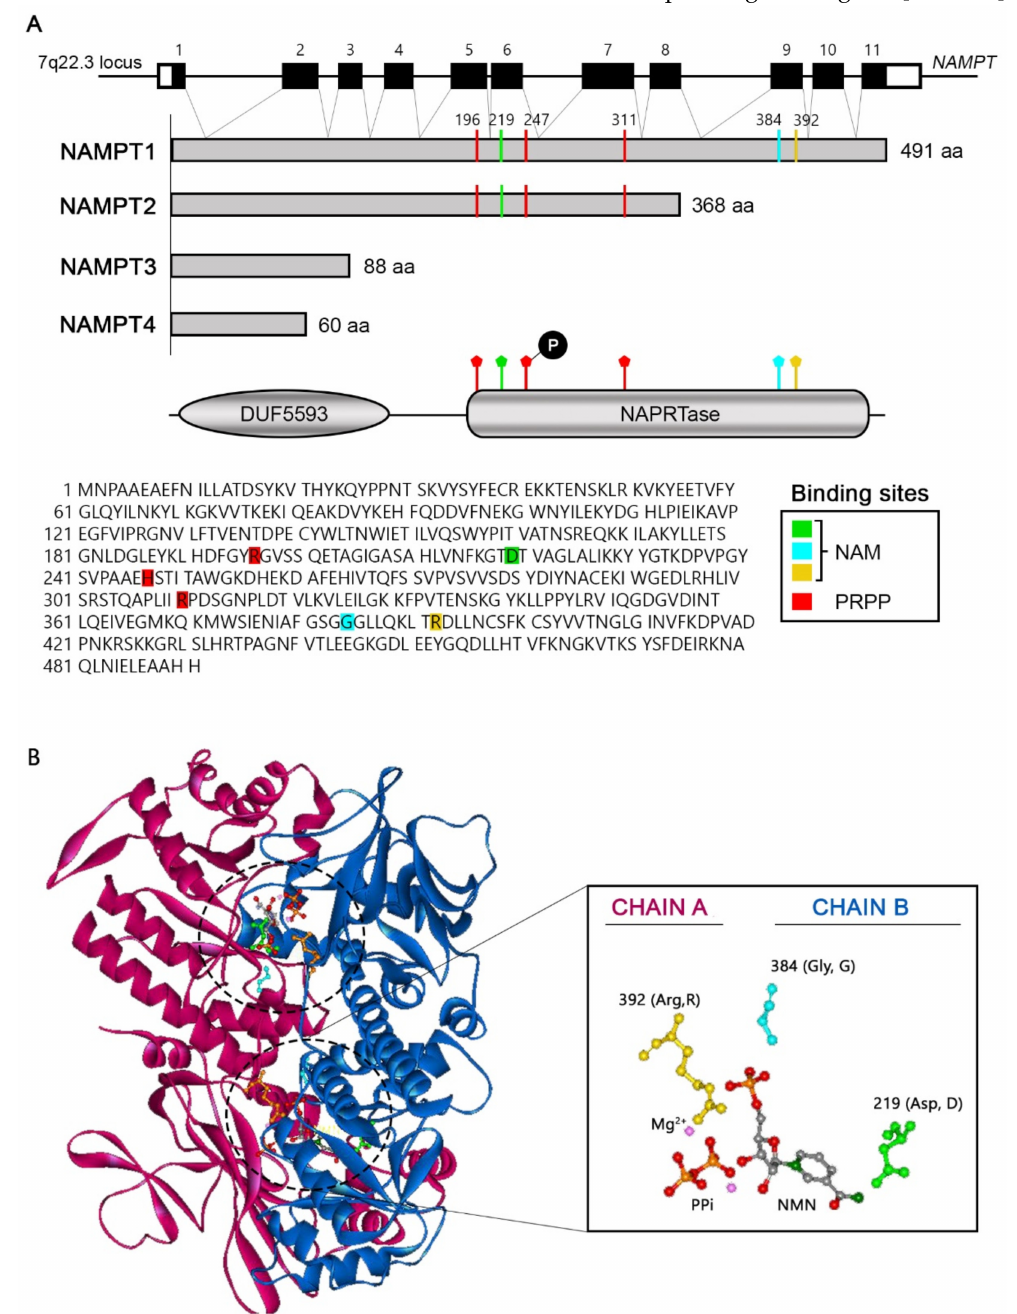
Figure 3. Structure of the NAMPT gene and protein. ( A ) The NAMPT gene contains 11 exons and 10 introns that are translated into 4 possible variants by alternative splicing or splicing. NAMPT1 is the predominant variant and the only one that has enzymatic activity. The protein contains 2 domains, DUF5593 and NAPRTase, in which the amino acids that form the catalytic site of NAM (D219, G384 and R392) and PRPP (R196, H247 and R311) are located. H247 aa must first be phosphorylated by ATP hydrolysis for NMN synthesis to take place. ( B ) Crystal structure of the NAMPT functional homodimer (3DHF; https://www.rcsb.org/structure/3DHF, Accessed on 1 April 2022). Catalytic sites are marked with dashed